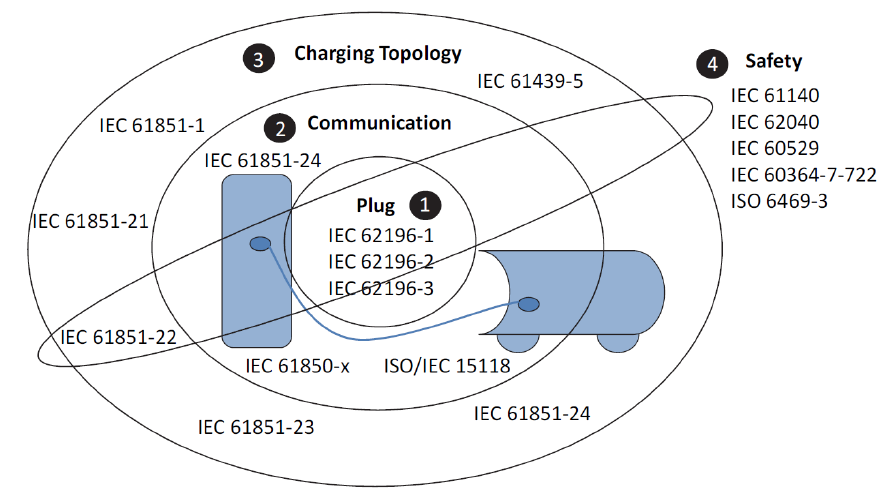
Figure 18. Standards on charging processes of electric vehicles.